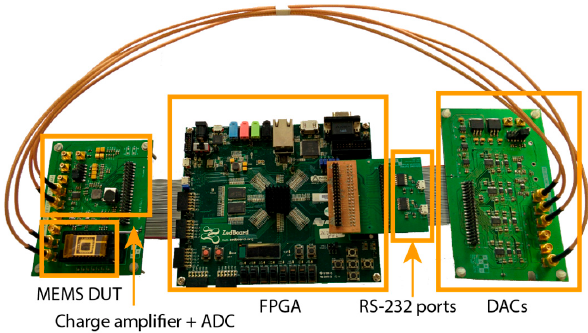
Figure 7. Image of the prototyped digital platform.